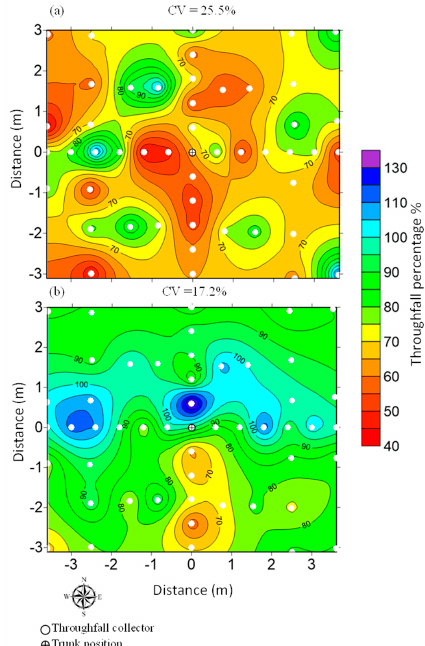
Figure 5. The results of cross validation of throughfall estimation during the ( a ) leafed and ( b ) leafless periods. The kriged maps show that TF concentrated at the canopy edge during both the leafed and leafless periods (Figure 6). The coefficient of variation (CV) of kriged map for estimating TF was higher in the leafed period than leafless period (25.5% vs. 17.2%) (Figure 6).